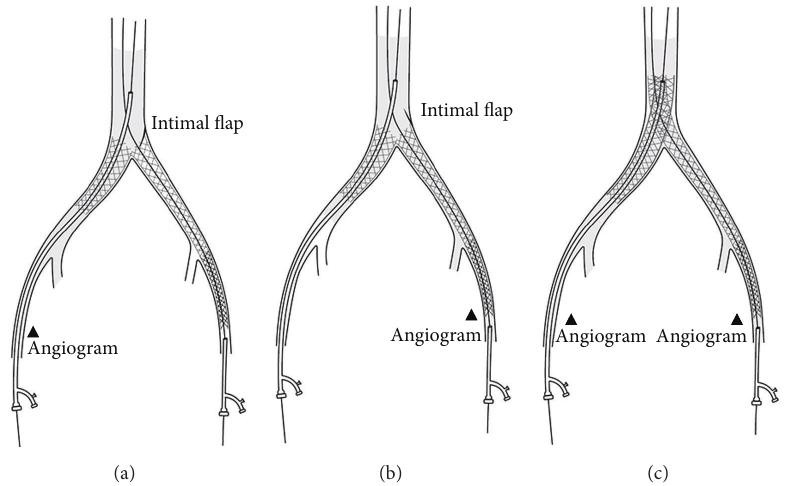
Figure 3: Schematic representation of the steps of the procedure and bailout kissing